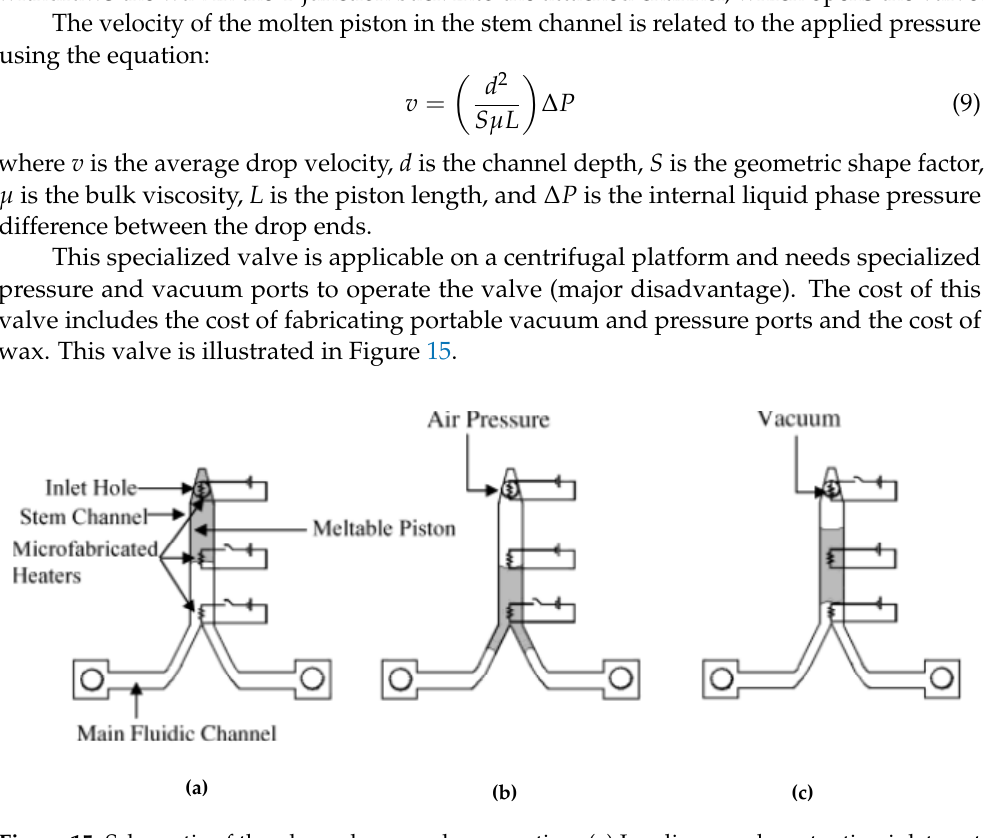
Figure 15. Schematic of the phase change valve operation. ( a ) Loading wax by actuating inlet port heater. ( b ) Closing valve by actuating the inlet port and stem channel heaters with pressure at inlet port. ( c ) Opening valve by actuating the stem channel and intersection heaters with vacuum at the inlet port. Permission granted by the publisher [59].